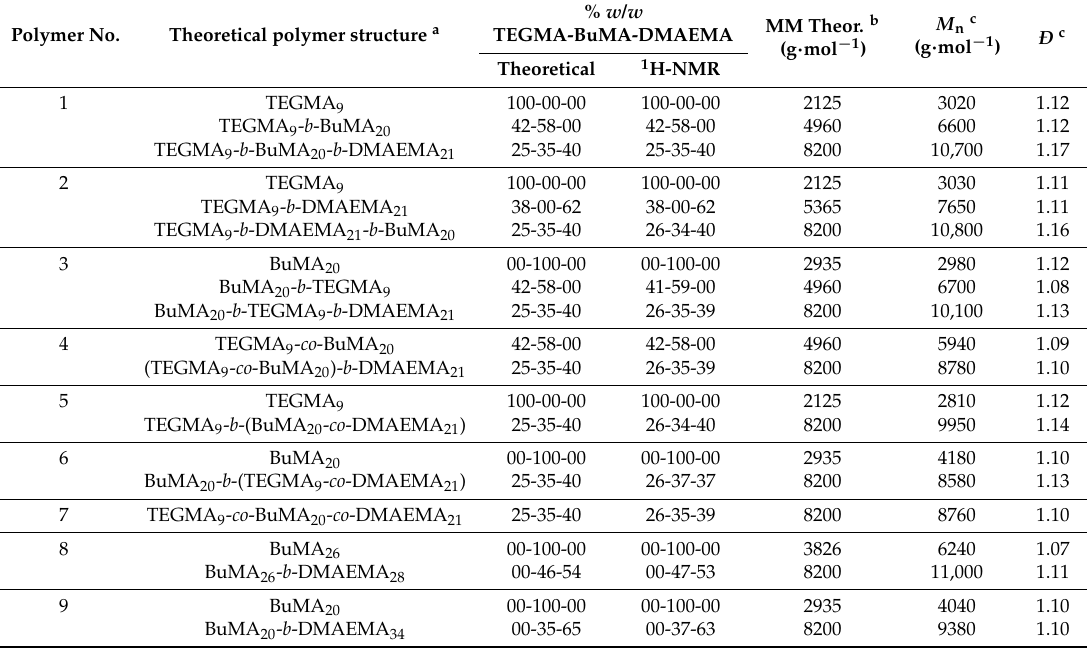
Table 1. Theoretical and experimental molar masses (MMs) and compositions, and molar mass distributions (MMDs) of the copolymers and their